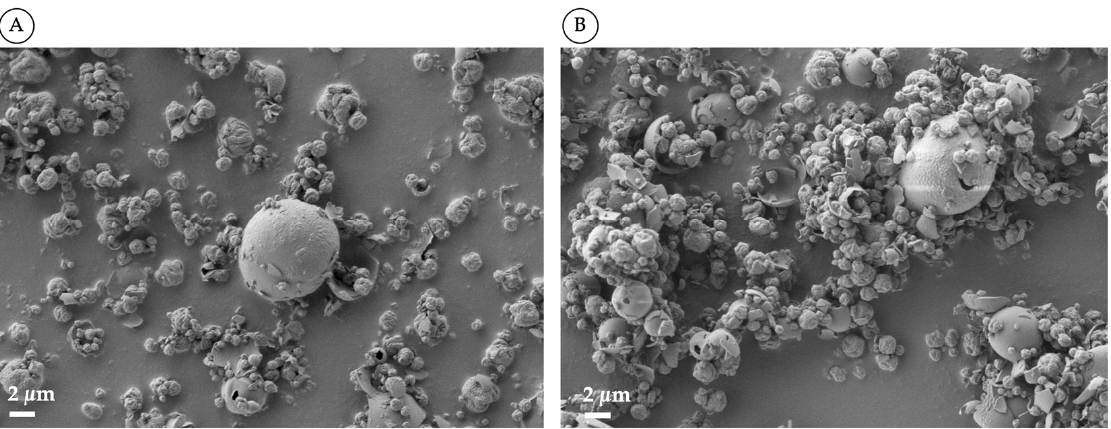
Figure 3. SEM images of CsA spray-dried powders produced with 45% ( v / v) ( A ) and 60% ( v / v) ( B ) of ethanol in the feedstock